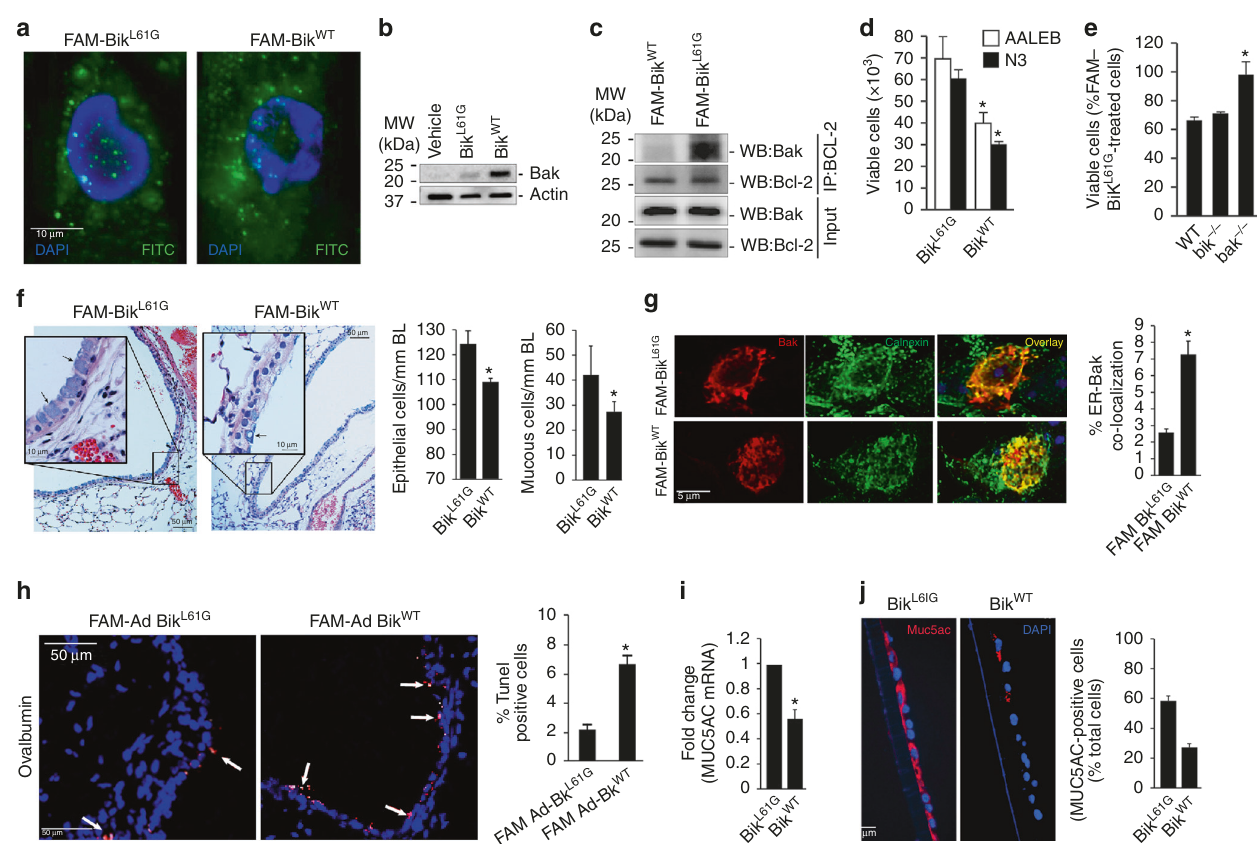
Fig. 6 Hydrocarbon-stapled Bik BH3 peptide is suf fi cient to activate Bak and reduce allergen- or CS-induced MCM, and ECH in vivo. a Confocal microscopy of HAECs treated with FAM-Bik WT or FAM-Bik L61G (1 μ M, 2 h) demonstrate suf fi cient uptake of peptides. b Protein lysates from HAECs treated with vehicle only, or 5 µ M of FAM-Bik WT or FAM-Bik L61G were analyzed for Bak expression by western blotting. c Protein lysates from HAECs treated